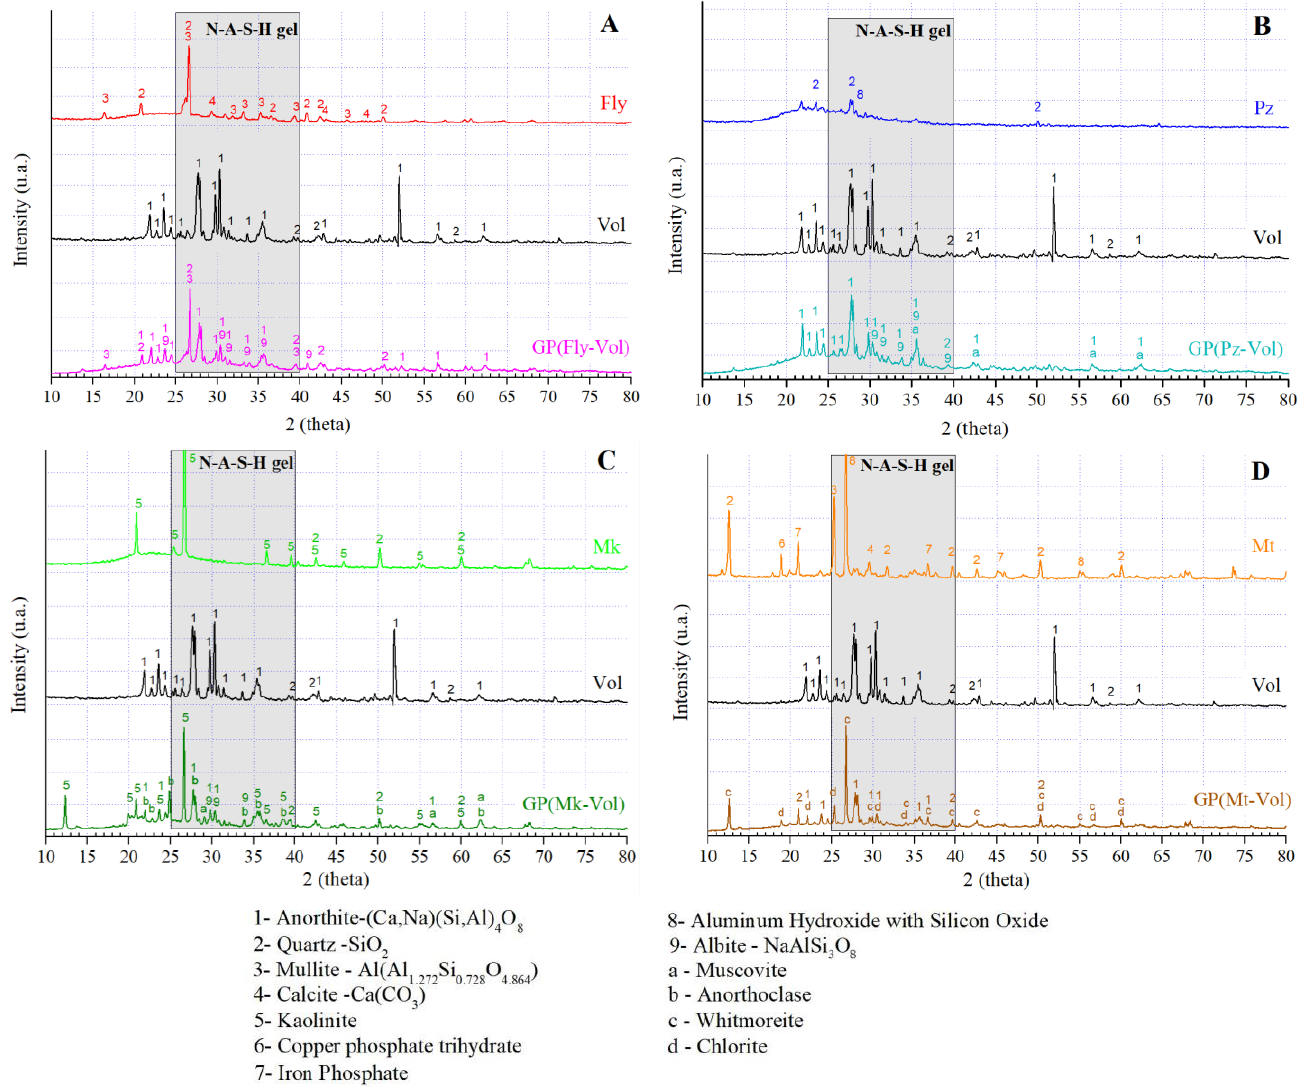
Figure 1. XRD patterns of raw materials (Vol, Fly, Pz, Mk, and Mt) and geopolymers. ( A ) Miner- alogical phases of Fly, Vol, and GP(Fly-Vol). ( B ) Mineralogical phases of Pz, Vol, and GP(Pz-Vol). ( C ) Mineralogical phases of Mk, Vol, and GP(Mk-Vol). ( D ) Mineralogical phases of Mt, Vol, and GP(Mt-Vol).